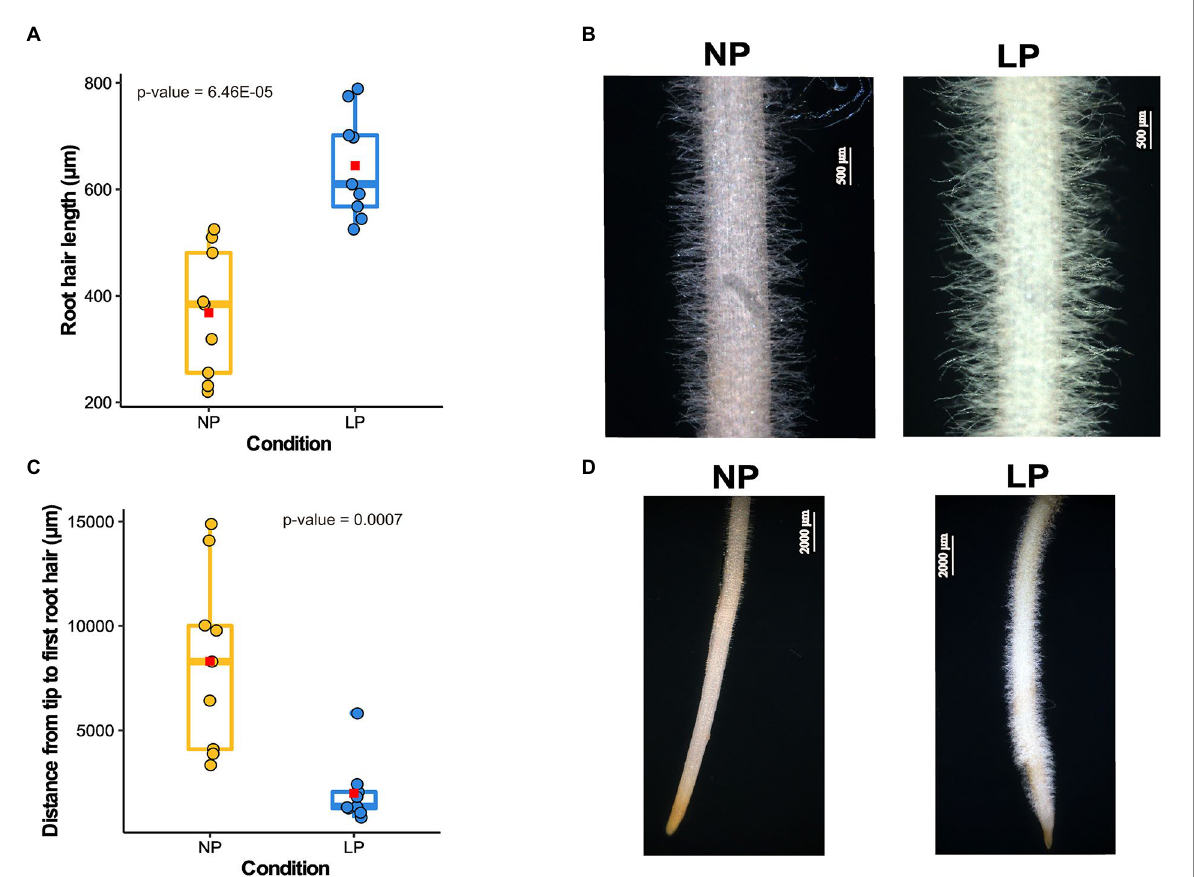
FIGURE 1 Root hairs (RH) growth response to low phosphorus (LP) in chickpea. (A) Box plot depicts the difference in RH length in normal phosphorus (NP) and LP conditions ( n = 9). The x -axis represents the RH length, and the y -axis denotes different conditions. The average RH length for each condition is represented on the box plot as a red square, and value of p shows the significant difference calculated using a two-tailed t -test. (B) The microscopic images of the mature zone of chickpea root depicting the visual difference in RH length in NP and LP conditions. (C) Box plot displays the difference in the distance from the first visible RH to the root tip ( n = 9). In this plot, the x -axis represents the distance from the root tip to the first visible RH, and the y -axis denotes different conditions. The average distance for each condition is designated as a red square, and the value of p shows the significant difference calculated using a two-tailed t -test. (D) Images of chickpea root in NP and LP conditions show the ectopic RH in LP near the root tip, resulting in a shorter distance from the root tip to the first visible